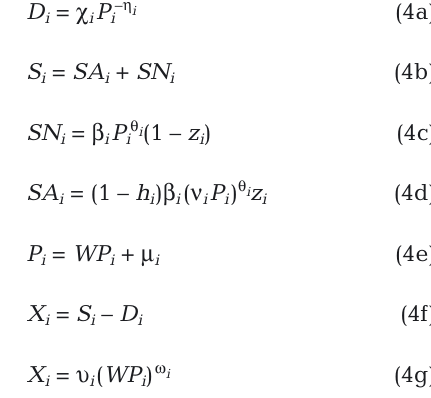
marine farming areas. The sum of the changes in consumer and producer surpluses is equivalent to changes in total societal welfare (Table 3).